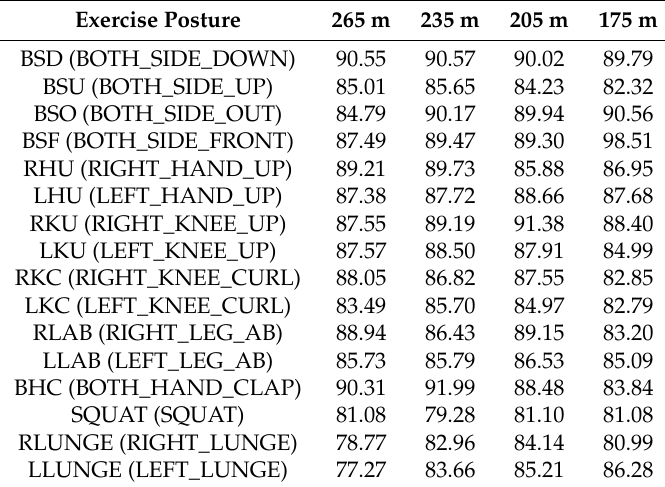
Table 3. Average Rate of Posture